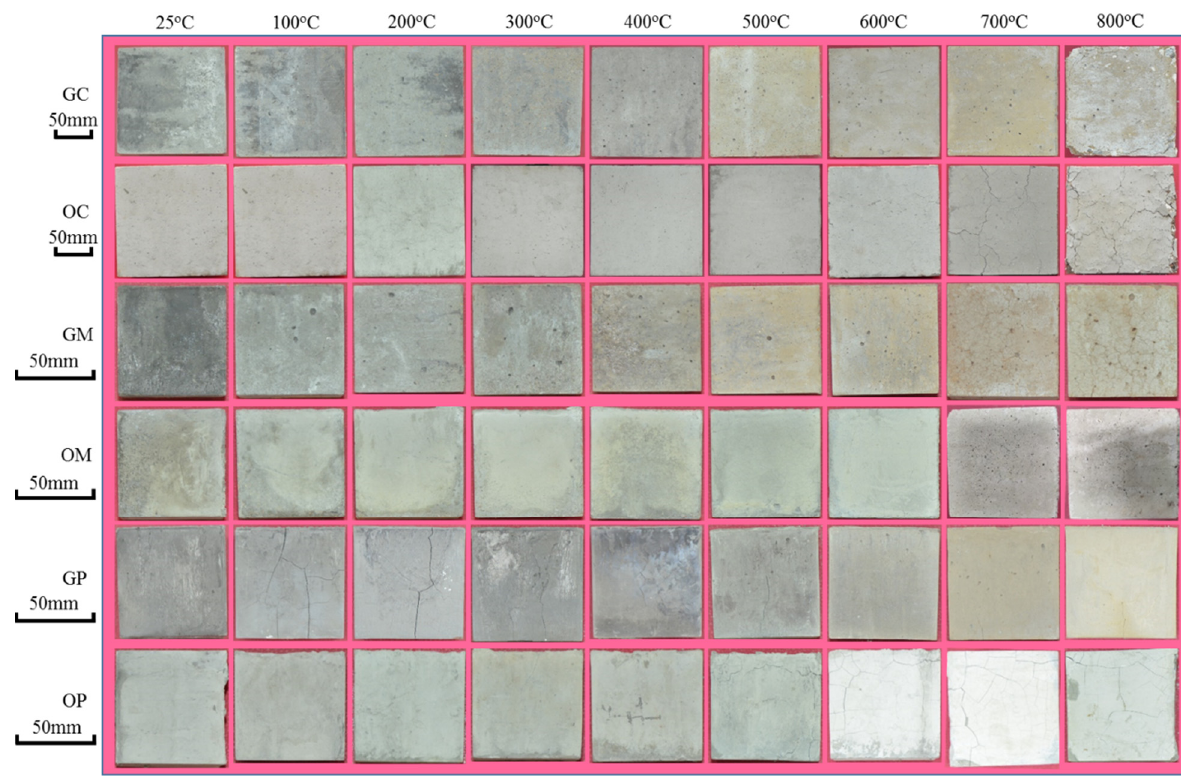
Figure 5. Change of surface morphology of geopolymer and ordinary concrete, mortar and paste (all specimens with grade of